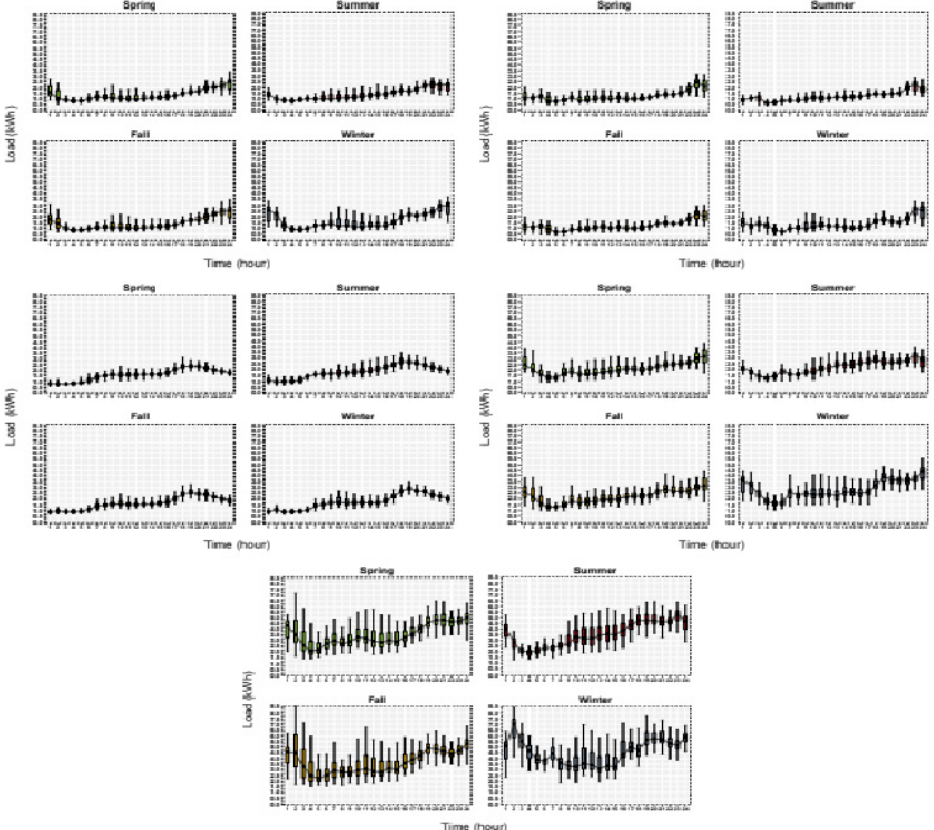
Figure A1. ( top left ) Box plot of loads of all customers in bin 1 for 24 h. ( top right ) Box plot of loads of all customers in bin 2 for 24 h. (middle left) Box plot of loads of all customers in bin 3 for 24 h. ( middle right ) Box plot of loads of all customers in bin 4 for 24 h. ( bottom ) Box plot of loads of all customers in bin 5 for 24 h.